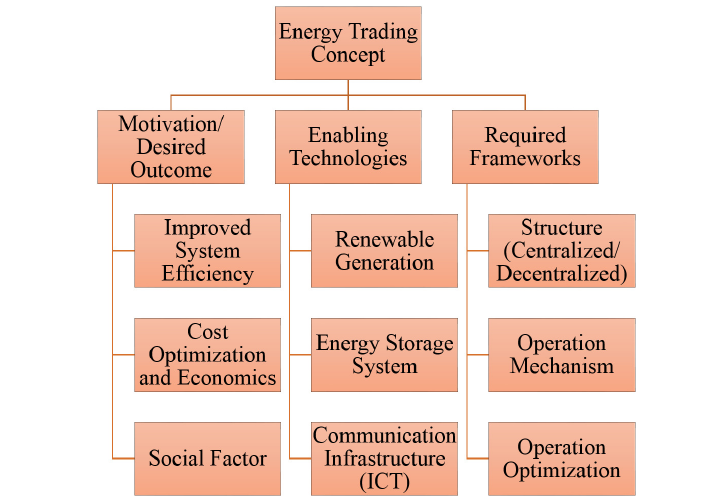
Figure 1. Overview of the energy trading concept (adapted from [10]). ICT: information and communication